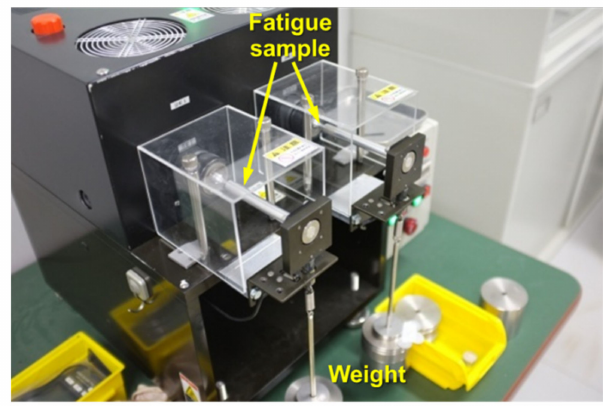
Figure 4. Rotation-bending fatigue